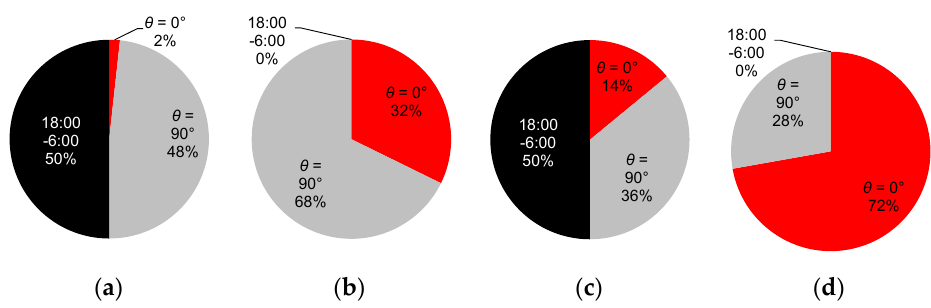
Figure 12. Duration percentage of night-time (18:00–6:00) and day time at θ = 0° and 90° in winter (( a ), 8 December to 13 February) and in spring (( c ), 15 February to 25 April); the percentage of the PV-module generated energy during night-time and day time at θ = 0° and 90° in winter ( b ) and in spring ( d ).